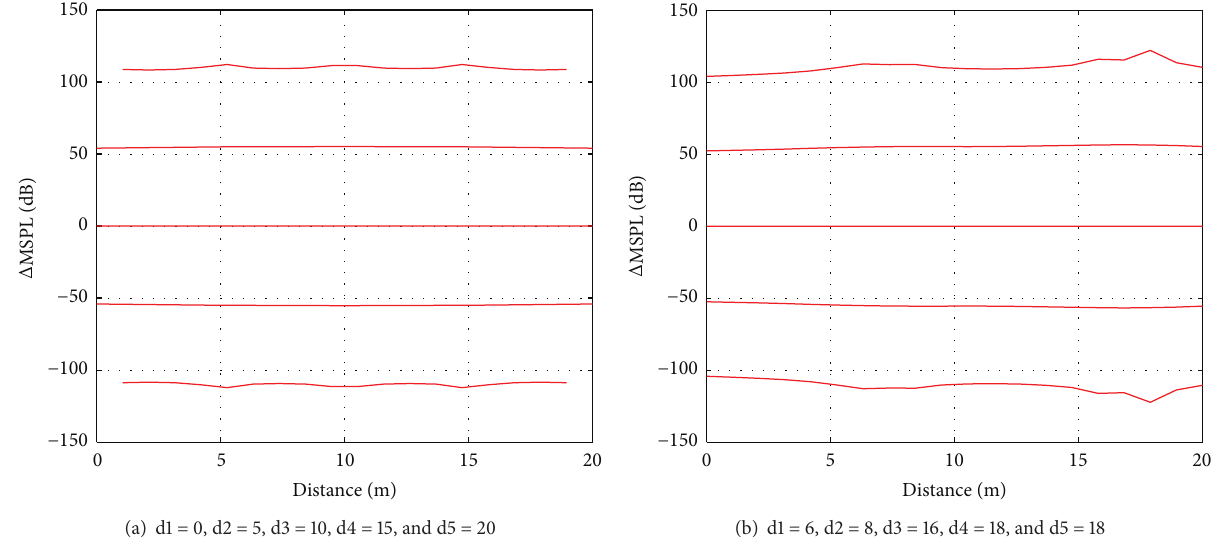
Figure 5: Δ MSPL with 5 anchor